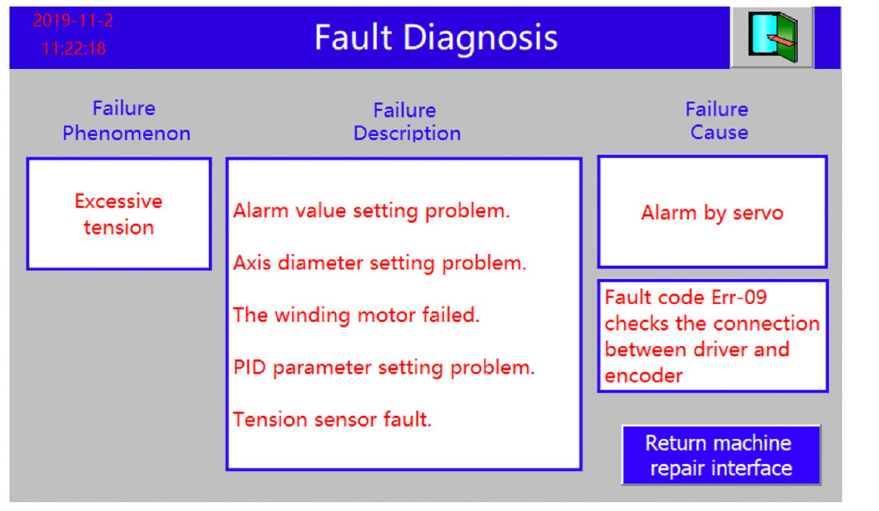
Fig 6. Field human-computer interaction fault diagnosis